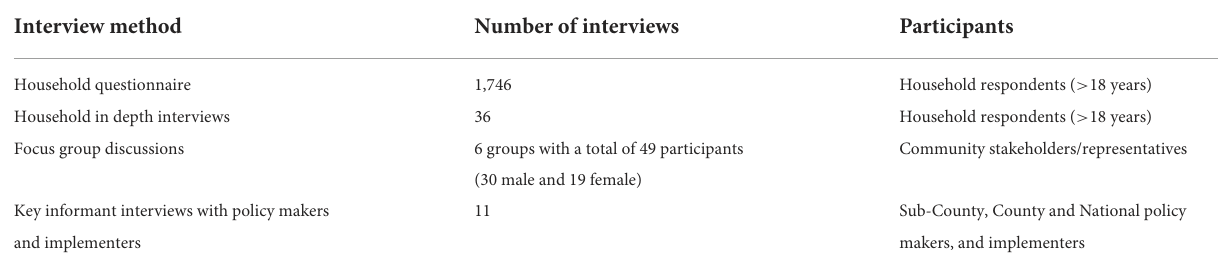
TABLE 1 Data collection method and study